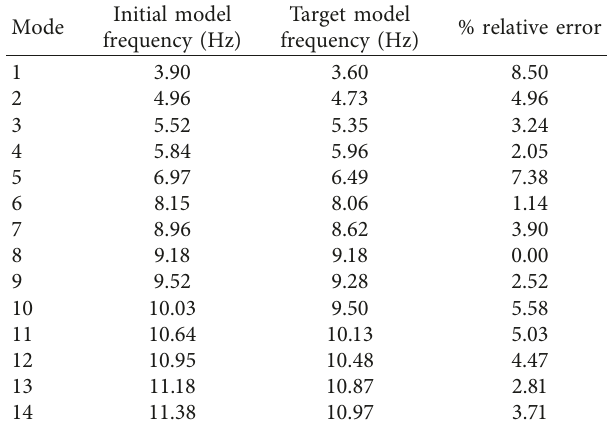
Table 14: Natural frequencies for configuration 5.